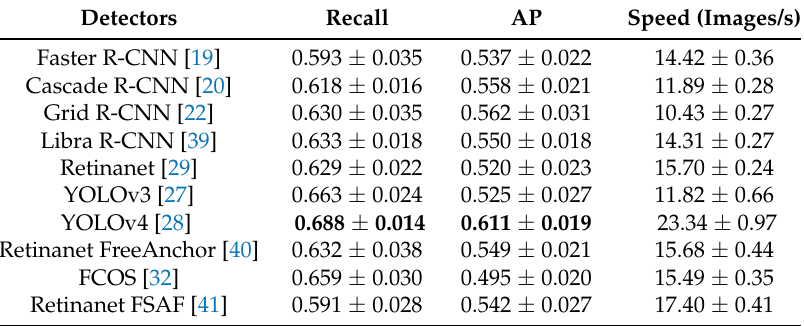
Table 11. Results on the EPD-C subset. Train resolution, 1–2 m/pixel; test resolution, 2 m/pixel. AP refers to average precision. Recall, AP, and speed are expressed in the format of mean ± standard deviation on the basis of 10 rounds of test results.